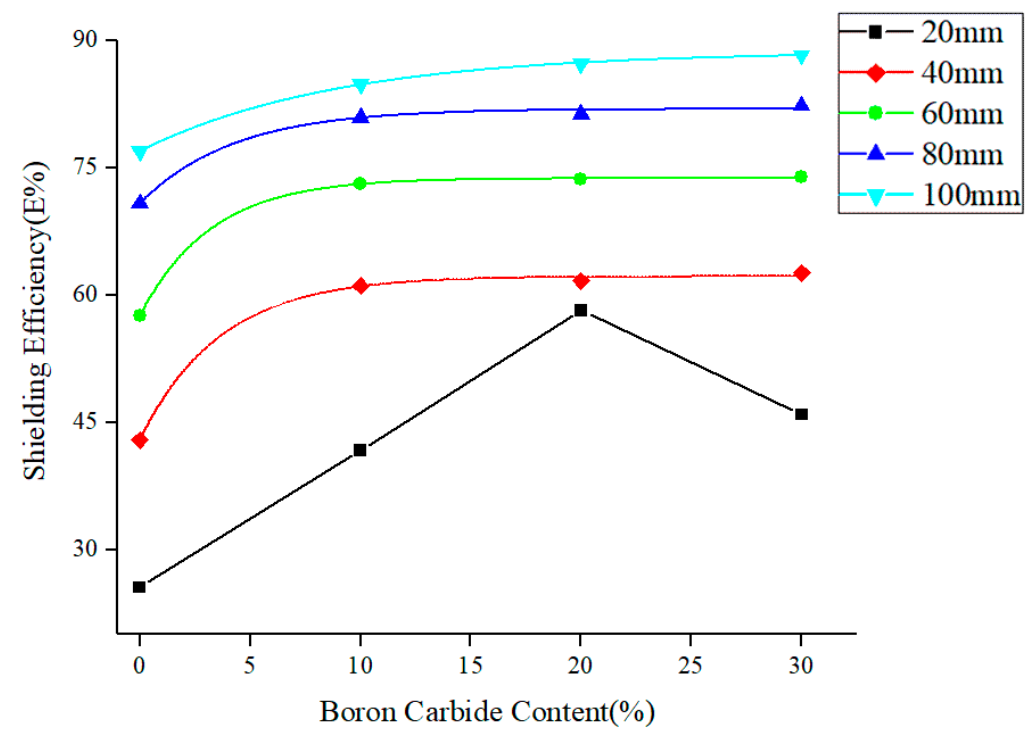
Figure 11. Shielding performance of PEEK / boron carbide PEEK on the Am-Be neutron source.